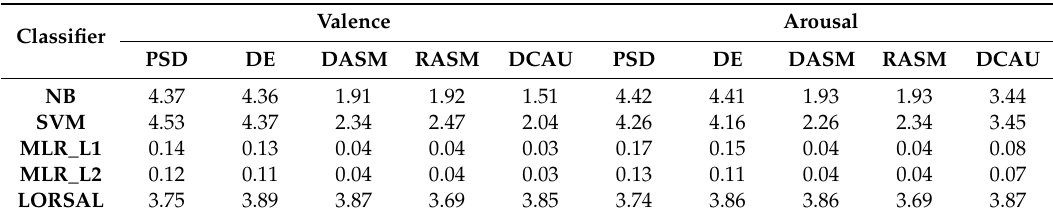
Table 6. Running time of the compared NB, SVM, MLR_L1, MLR_L2, and LORSAL methods in terms of second and the average time-consumption of feature extraction is 68.15